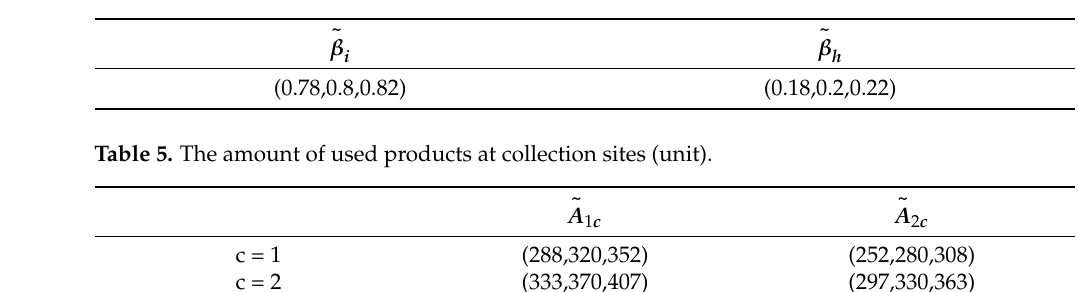
Table 4. The average percentage of recycling materials and disposal items generated from recycling centers.